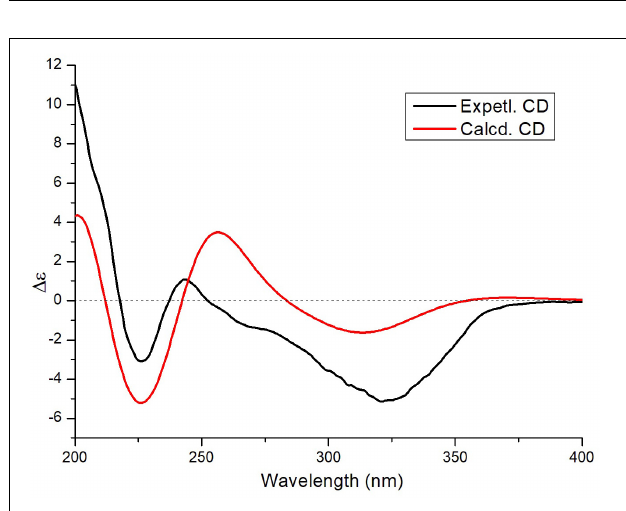
FIGURE 3 | Experimental and theoretical ECD spectra of compound 1.